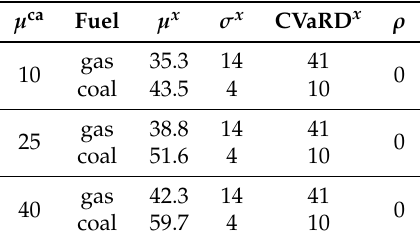
Table 2. Expected EECs and risk measures values ($ 2015/MWh) in the σ ca = 0 scenario for µ ca = 10, 25, 40. CVaRD, Conditional Value at Risk